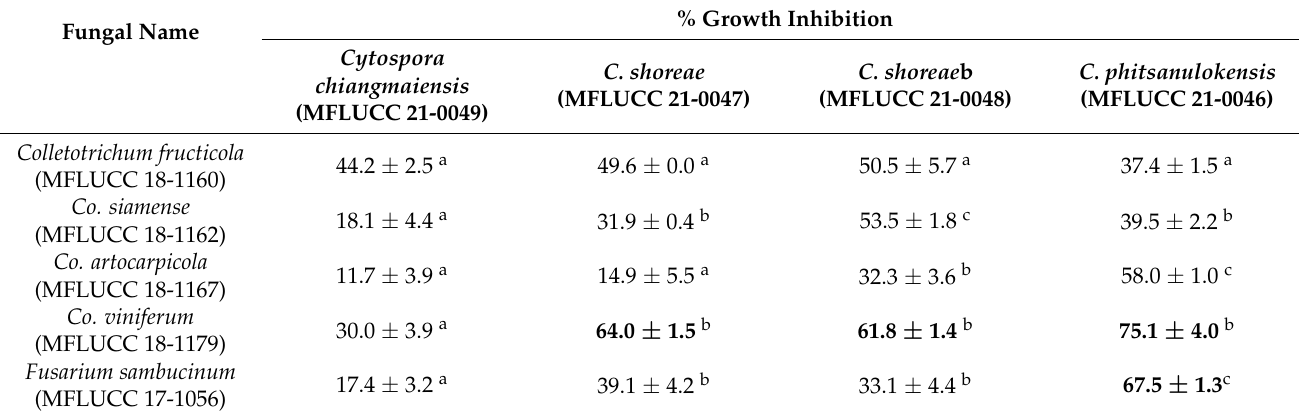
The values represent I% ± S.E. Different letters indicate significant differences between tested pathogens ( p ≤ 0.05) according to Tukey’s HSD test. The values greater than 60% with clear inhibition zone are